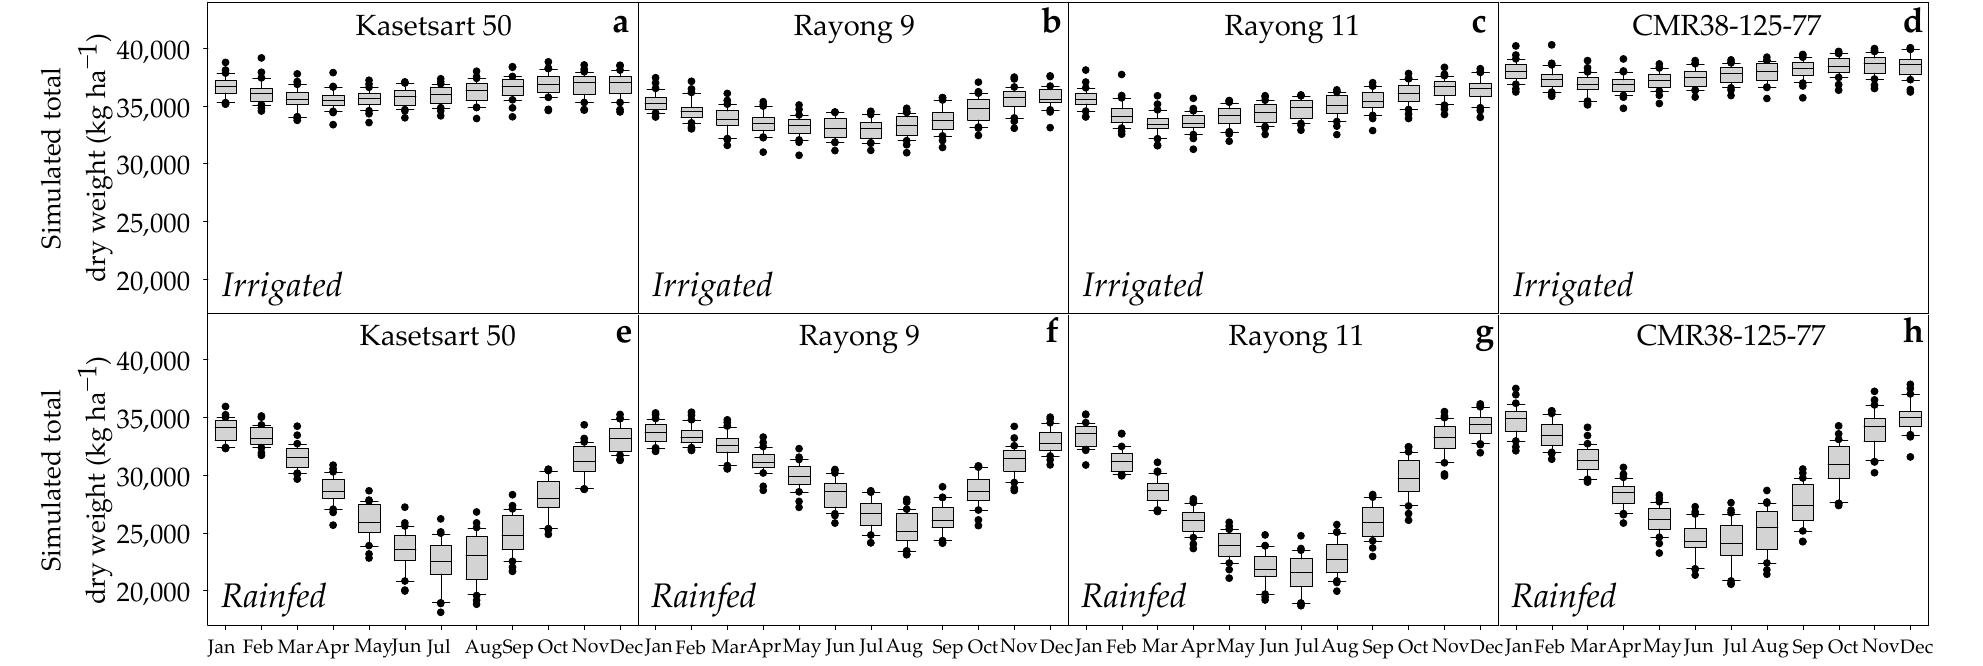
Figure 3. Means over ten locations and 30 years (1988–2018) of simulated total biomass for Kasetsart 50, Rayong 9, Rayong 11, and CMR38–125–77 at 12 different planting dates and under irrigated ( a – d ) and rainfed conditions ( e – h ). Box limits represent the 25th and 75th percentiles; box central line represents the median and the outliers represent the minimum and maximum values.